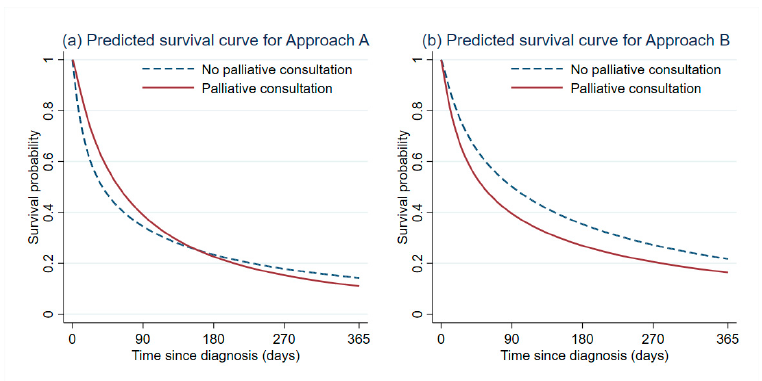
Figure 3. Predicted survival curve based on flexible parametric survival regression for approach A and approach B (limiting the analysis at 1 year after HCC diagnosis).